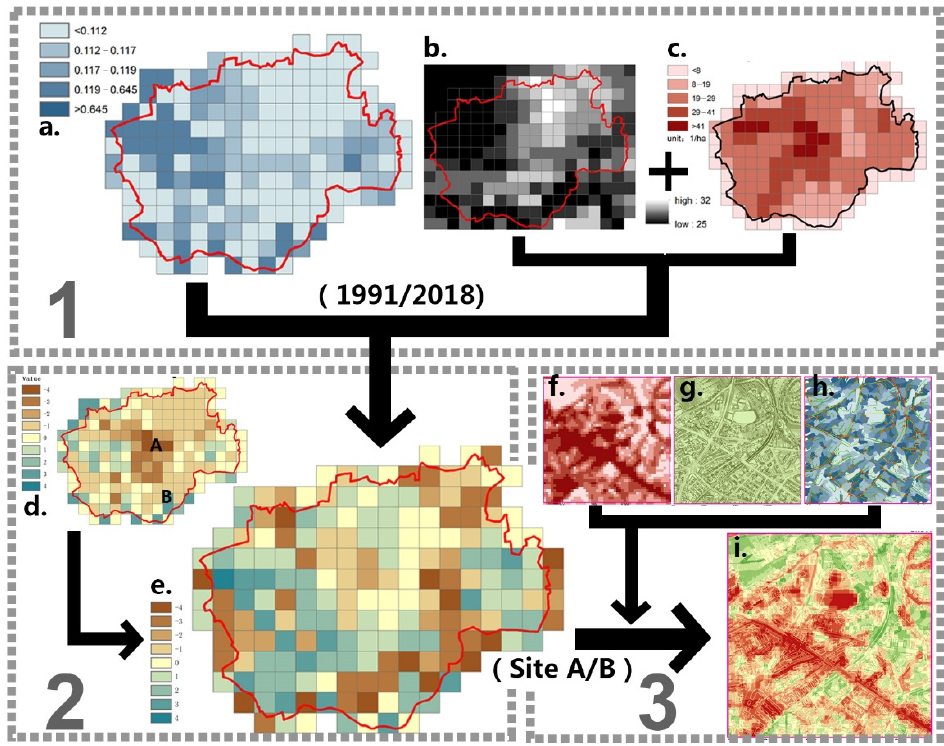
Figure 5. Flow graph of the approach for assessing water-flow-regulating ESs. ( a ) mapping of water- flow-regulating capacity on the macroscale; ( b ) mapping of drought index on the macroscale; ( c ) mapping of population density on the macroscale; ( d ) selection of oversupply and overdemand sites in 2018; ( e ) change of the supply – demand budget from 1991 to 2018 on the macroscale; ( f ) mapping of imperviousness ratio on the microscale; ( g ) mapping of slope on the microscale; ( h ) mapping of the area of water catchments on the microscale; ( i ) supply – demand budget mapping on the mi- croscale.